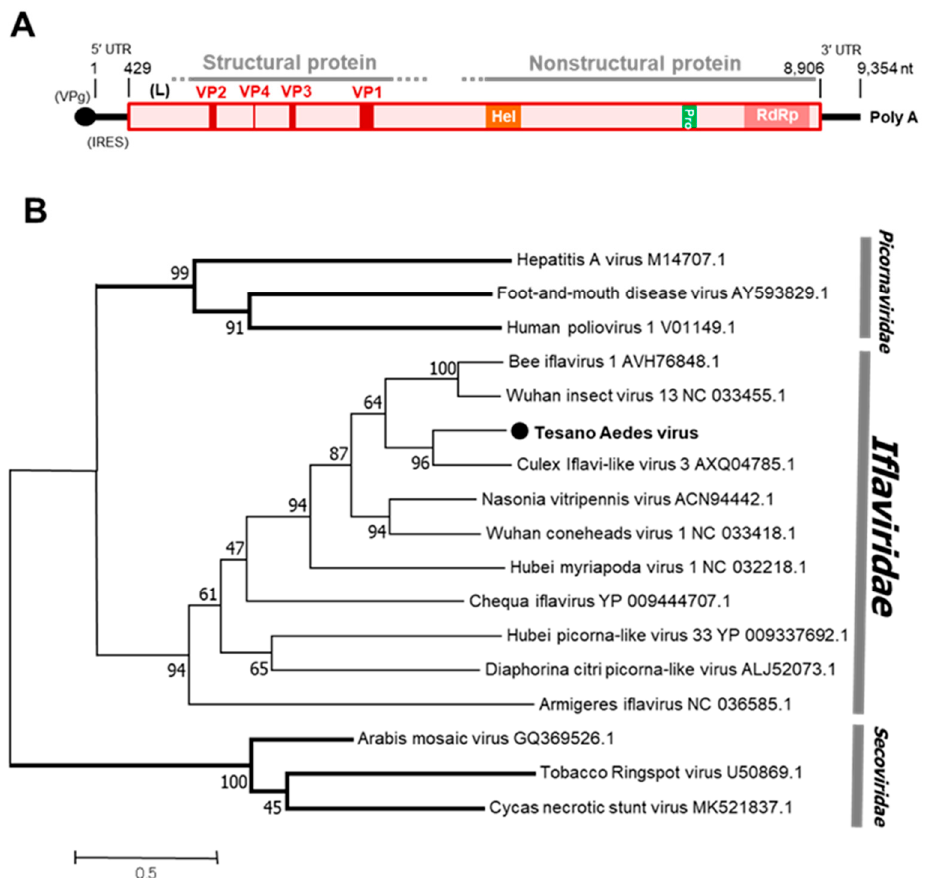
Figure 7. Genetic characterization of Tesano Aedes virus (TeAV). ( A ) Genome structure showing VPg and internal ribosome entry site (IRES) at the 5 ′ terminal and a poly-A tail at the 3 ′ terminal. ( B ) Genetic relationship between TeAV and other viruses of the family Iflaviridae . The maximum likelihood tree was constructed using the complete amino acid domain of the genome sequence with Genbank accession number LC496784. The amino acid domain was aligned using the MAFFT 7 online version [27]. Bootstrap support values from 1000 bootstrap replicates are indicated on the branches.